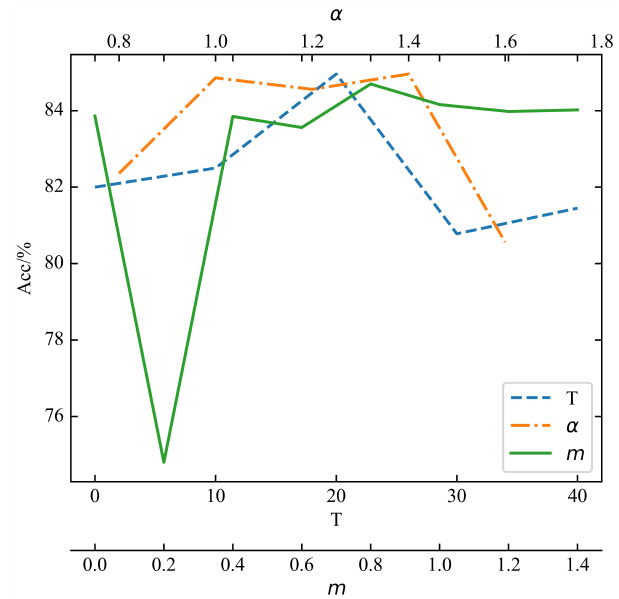
Figure 8. Result of hyperparameters’ searching.